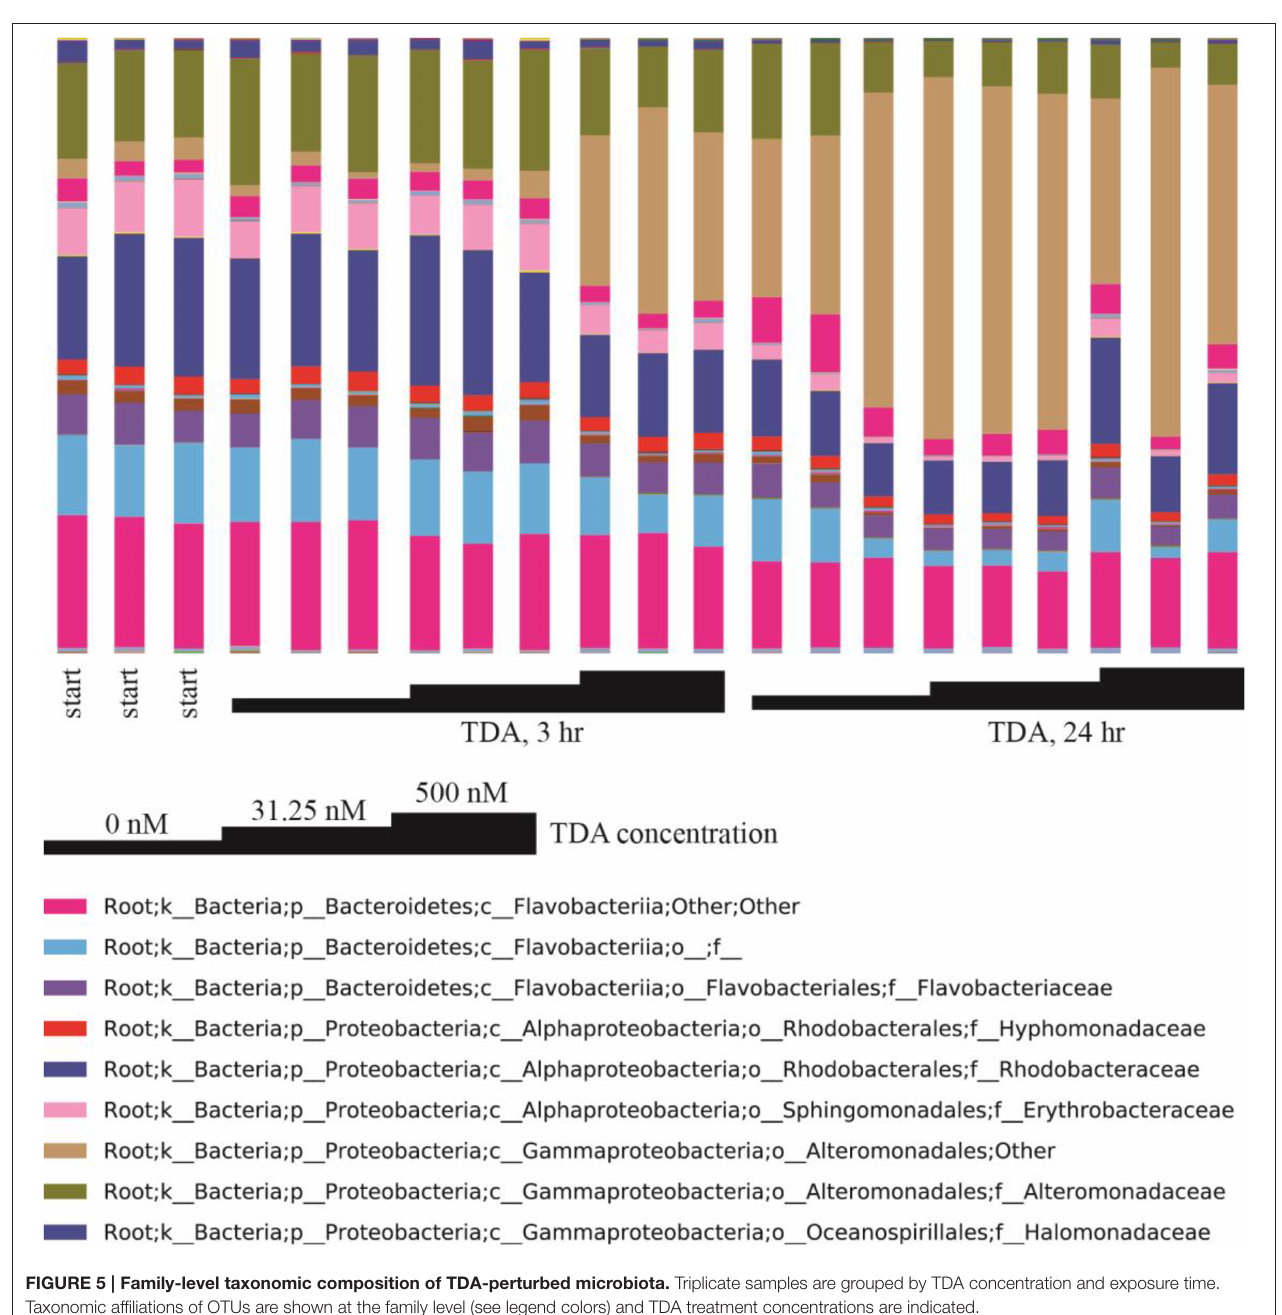
FIGURE 5 | Family-level taxonomic composition of TDA-perturbed microbiota. Triplicate samples are grouped by TDA concentration and exposure time. Taxonomic affiliations of OTUs are shown at the family level (see legend colors) and TDA treatment concentrations are